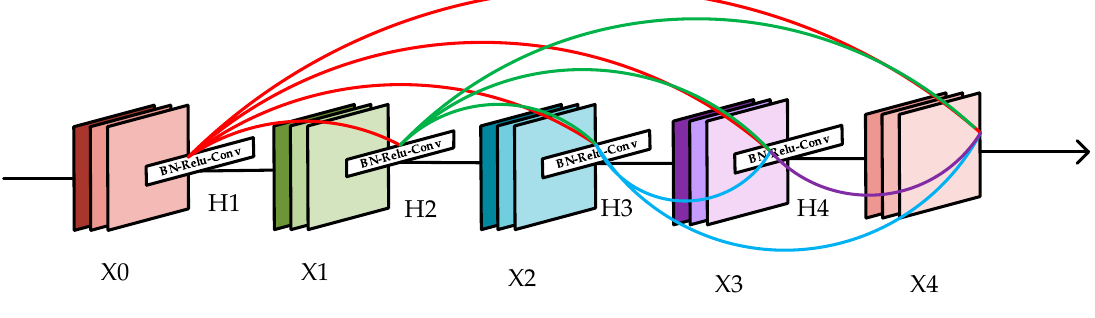
Figure 2. The structure of DenseNet.